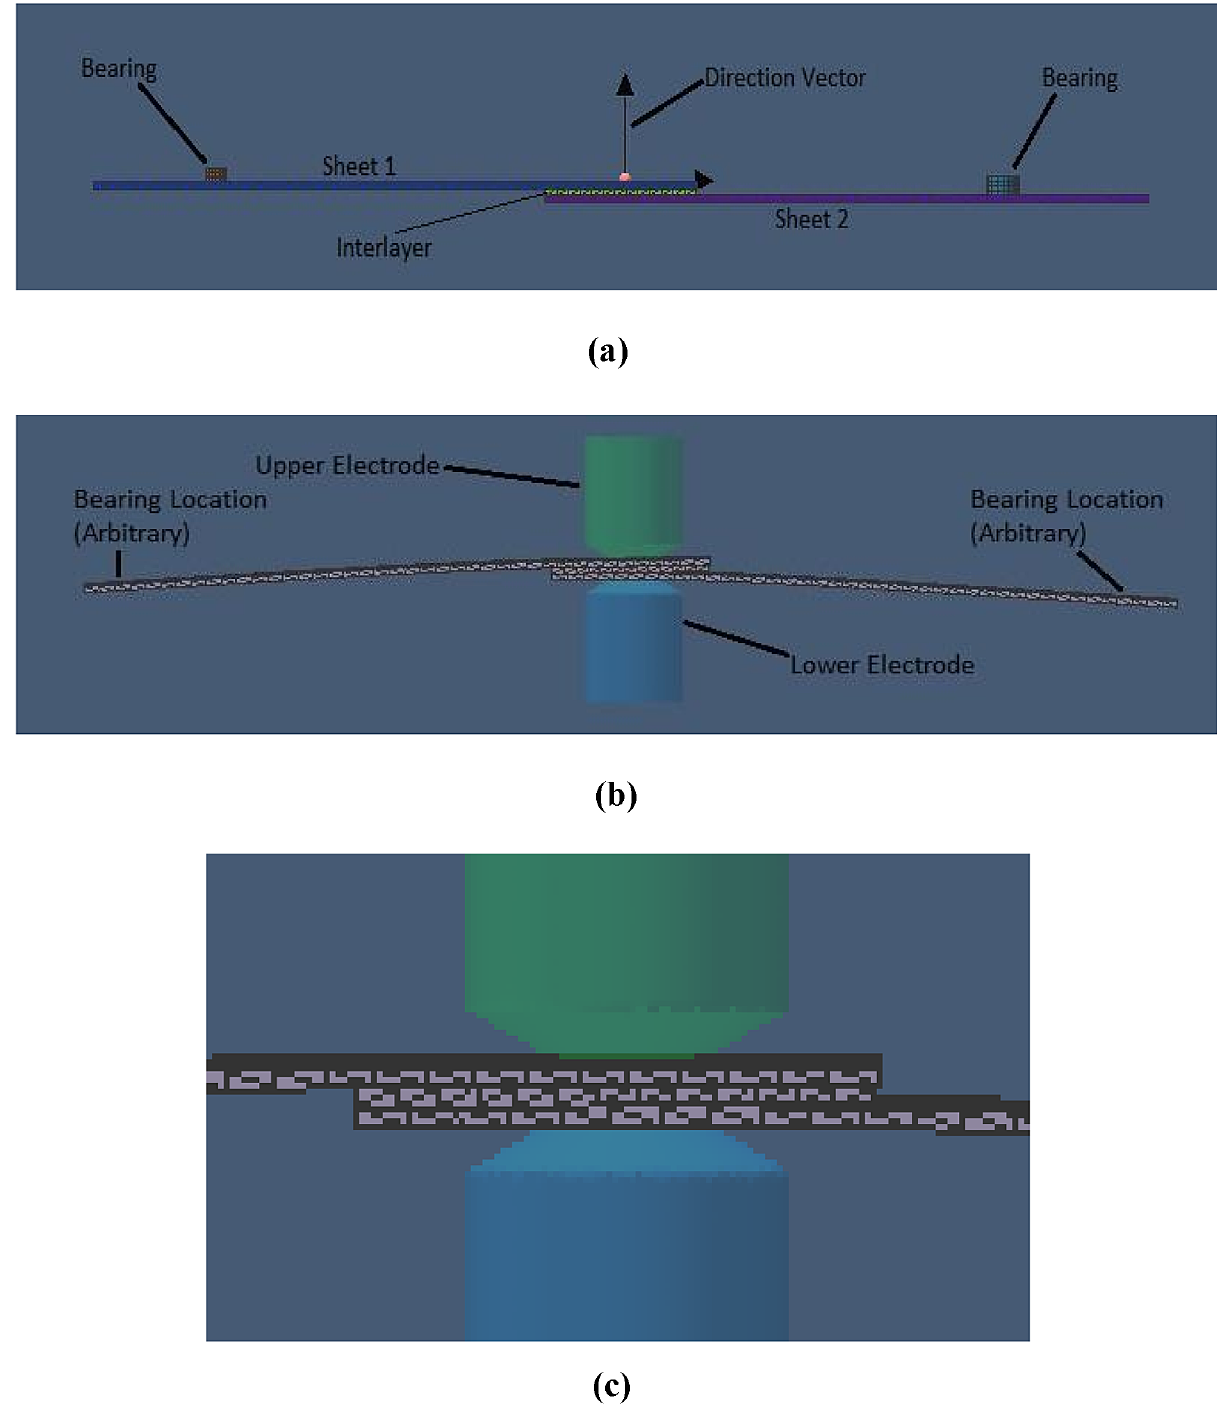
Fig. 9 a Geometry setup b Welding Procedure Simulation c Enlarged view of welding